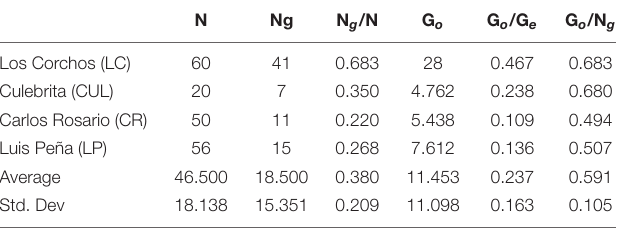
TABLE 2 | Genotypic diversity of A. cervicornis at source sites around Culebra, PR.